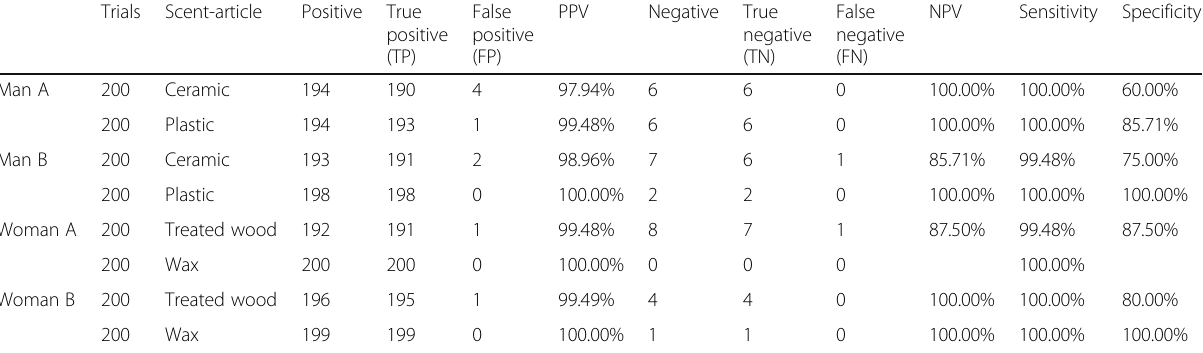
Table 5 Full experimental data on the human scent discrimination by the dogs Trials